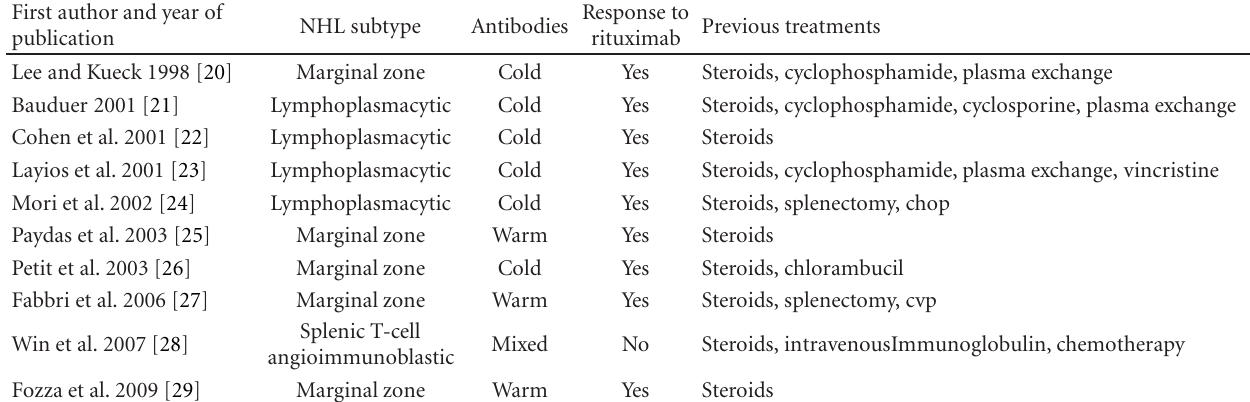
Table 1: Reported cases of non-Hodgkin lymphoma-associated autoimmune hemolytic anemia treated with